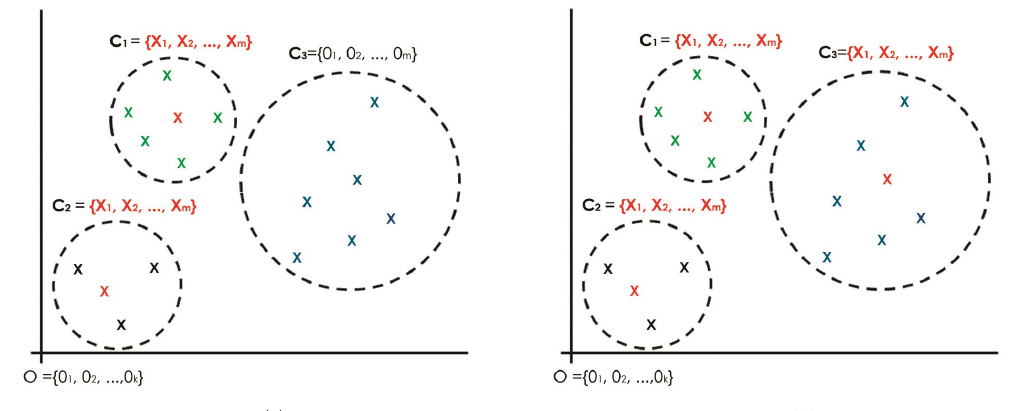
Figure 2. Proposed seeding approach with zero multidimensional spaces seeding regarding k-AMH numeric procedure. ( a ) Three clusters ( C 1 , C 2 , and C 3 ) initially refer to the same point: the origin. ( b ) Two clusters ( C 2 and C 3 ) initially refer to the origin, whereas C 1 has obtained the final object using k-AMH numeric procedure. ( c ) Remaining cluster C 3 initially refers to the origin, whereas C 2 has obtained the final object. ( d ) Final k-combination objects. Note: This concept will be implemented in the k-AMH framework where the process of finding the final medoids (Cluster center) involves checking for each object X i and replacing it, if the cost function is minimized. For the case above, the final cluster centers for C 1 , will be obtained first, followed by C 2 , and finally C 3 . The final cluster centers denoted as C 1 , C 2 , and C 3 are actually, and eventually, represented by the arbitrary objects X owing to the k-AMH